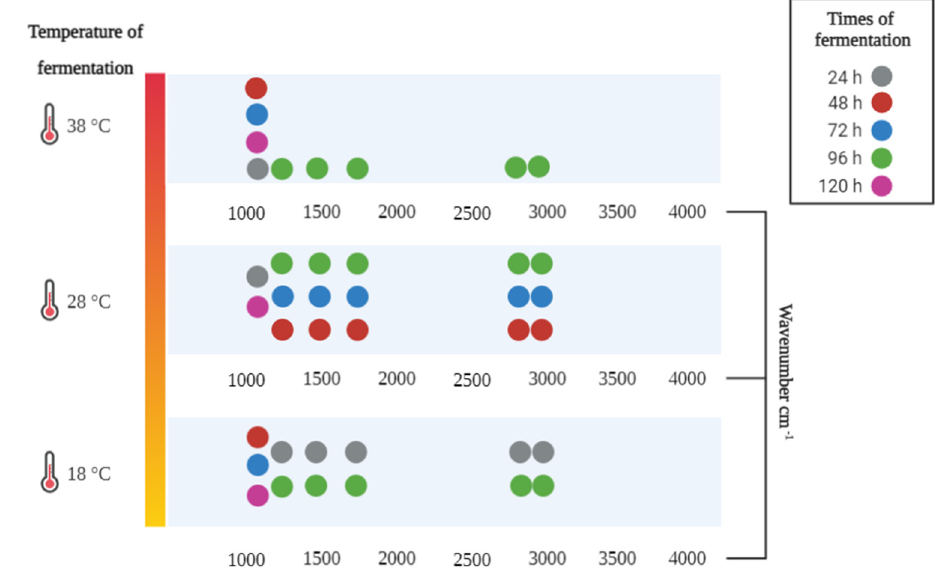
Figure 6. Coverage of fermentation times (24, 48, 72, 96 and 120 h) along the spectral regions as a function of fermentation times (18, 28 and 38 °C).